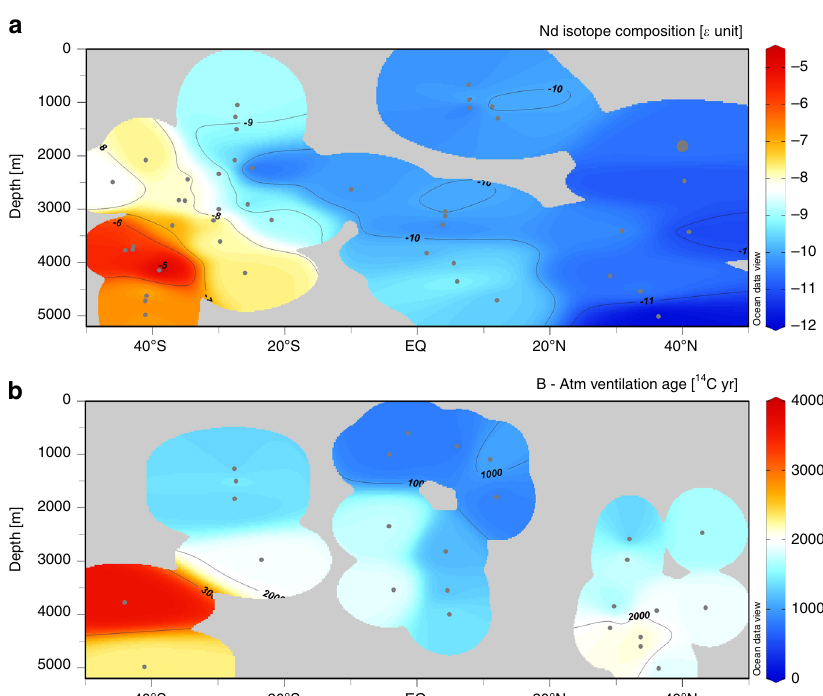
Fig. 5 Compilation of ε Nd and ventilation age data during the LGM (23 – 19 ka BP) from the western basin of the Atlantic. a Compilation of authigenic ε 14 C age differences between deep ocean samples and the contemporaneous atmosphere. Data locations are shown by dots, with the Nd . b Compilation of large one at 40°N in a representing our cores. See the Compilation of ε Nd and 14 C data section in “ Methods ” section for